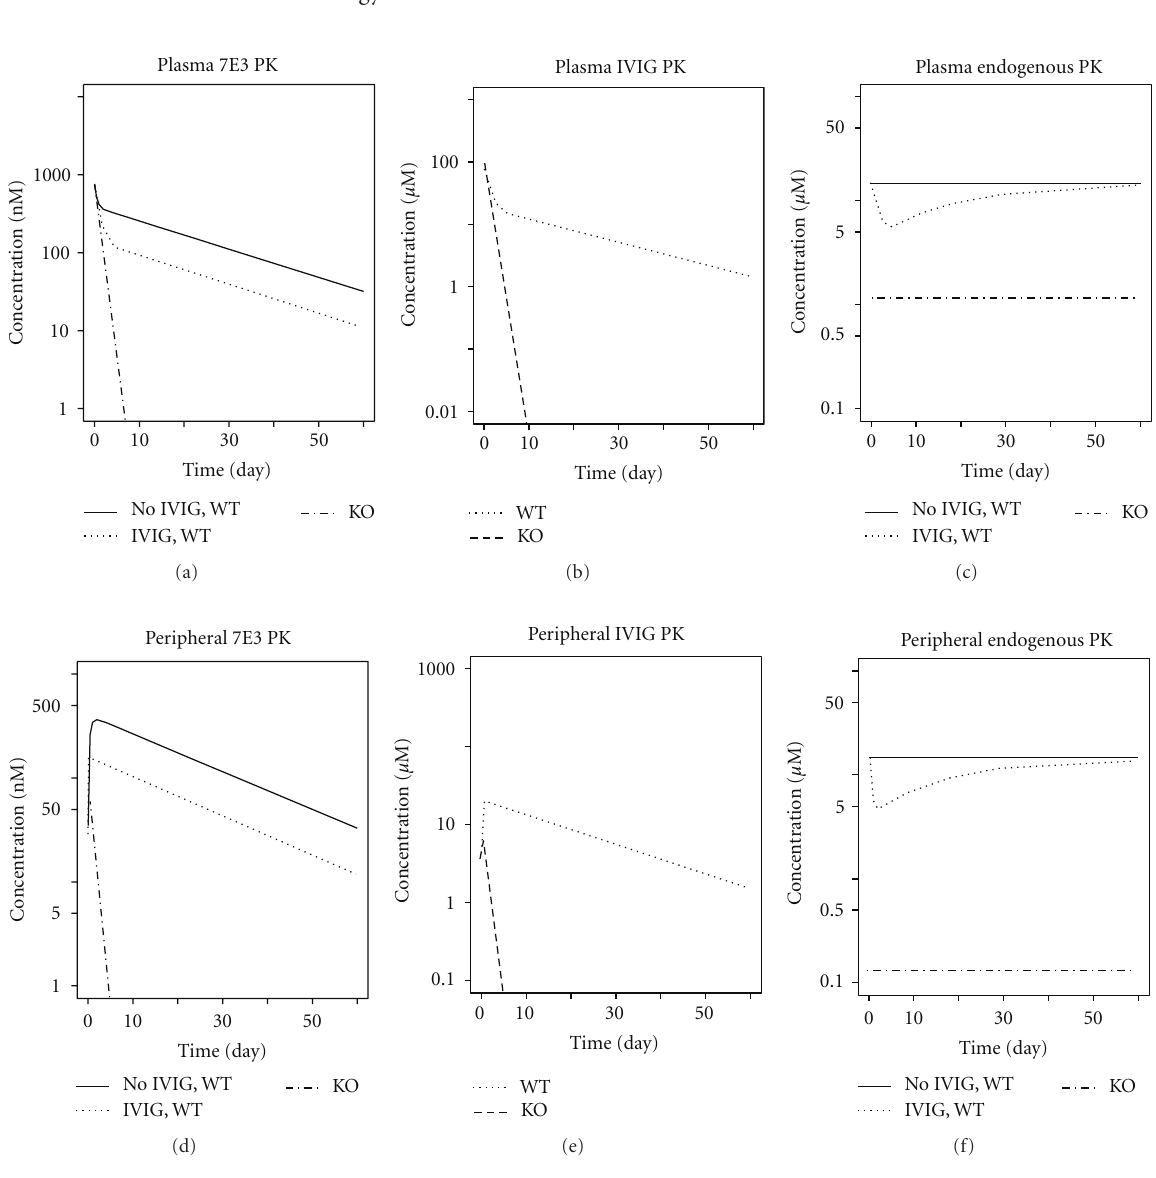
Figure 4: Simulated PK profiles using the mouse cuto ff model. All mice receive 8mg/kg 7E3 with or without concomitant 1g/kg IVIG in either FcRn WT or KO mice. Plasma and peripheral concentrations of 7E3, IVIG IgG, and endogenous IgG are